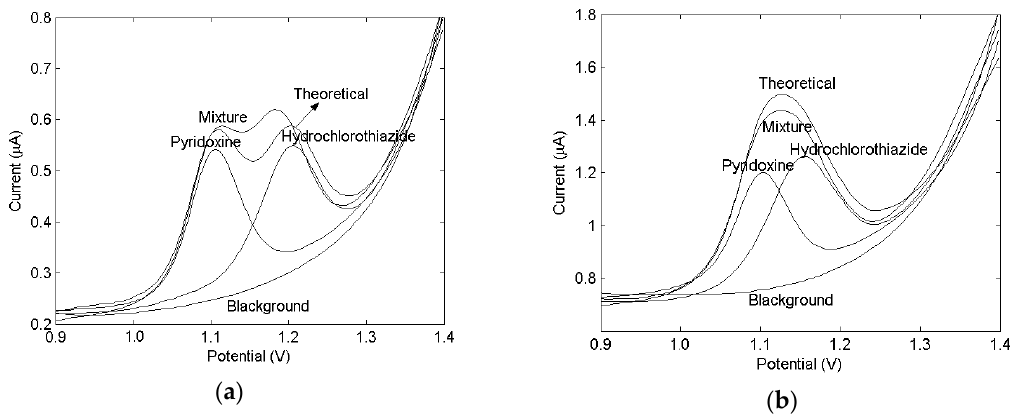
Figure 1. The differential pulse voltammograms (DPV) of 0.4 μ g/mL hydrochlorothiazide and 0.2 μ g/mL at the ethylenediamine-modified glassy carbon electrode ( a ) and bare glassy carbon electrode ( b ) respectively in the pH 3.4 B-R buffer.